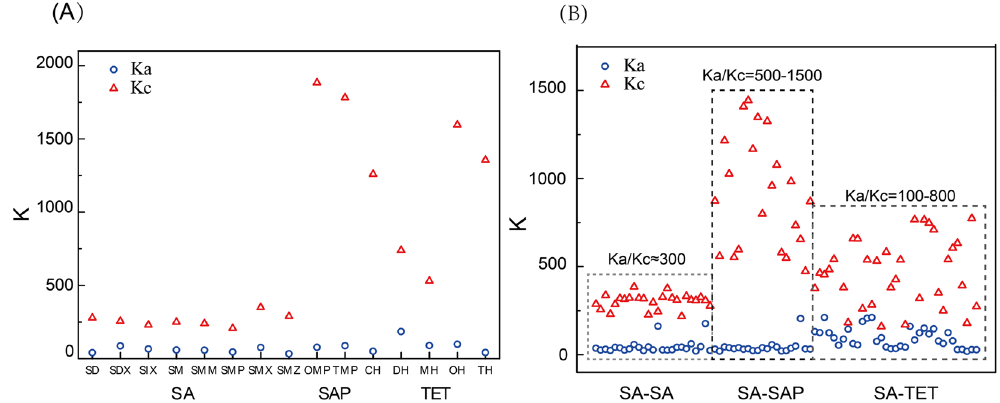
Figure 2. Comparisons between Ka and Kc of the single chemicals ( A ) and the binary mixtures ( B ).